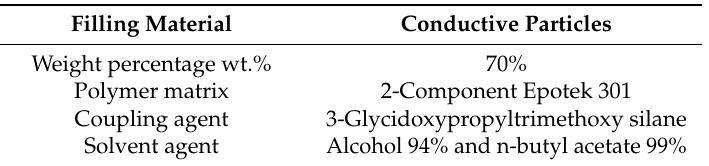
Table 1. Composition of particle based films.